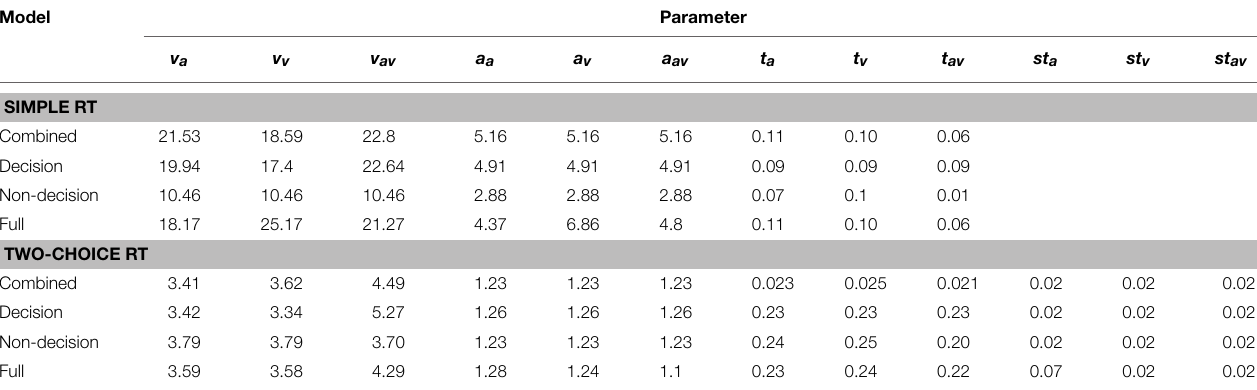
TABLE 5 | Parameter values of the fitted models, separately for Experiments 1 (simple RT) and 2 (two-coice RT). Model